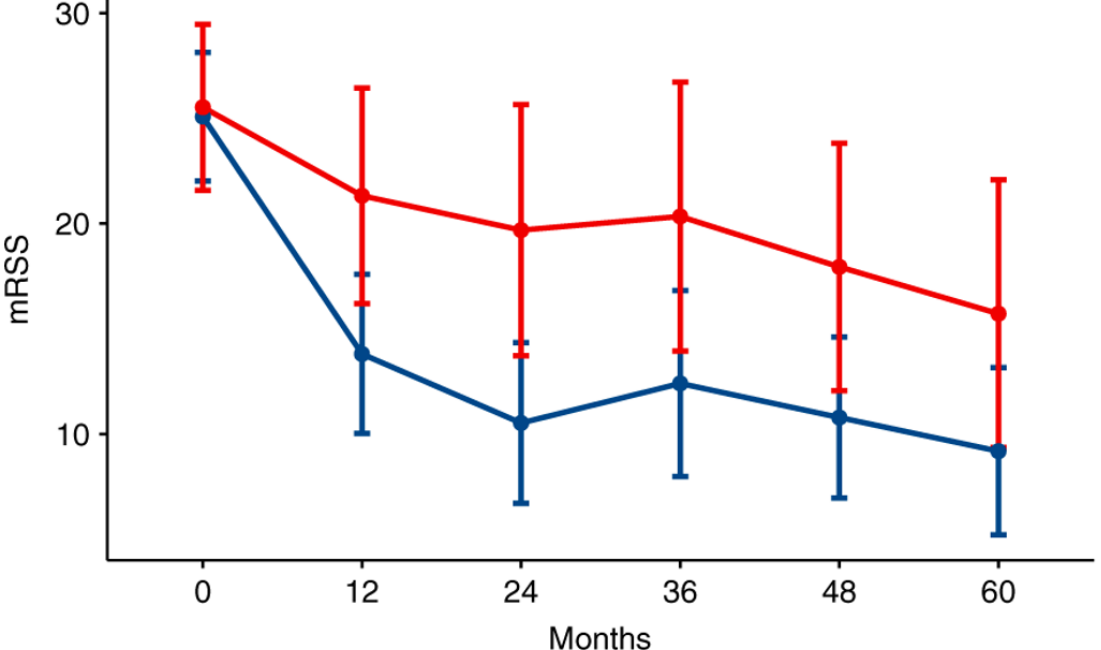
Figure 2. Change in modified Rodnan skin score [mRSS], where larger scores indicate worse skin tightness) over 60 months from randomization in 26 patients treated with autologous hematopoietic cell transplantation (auto-HCT: blue line) vs. 23 patients treated with conventional therapy (12 months of IV cyclophosphamide: red line) [67]. The skin tightness improved faster and to a greater degree after HCT compared to the conventional therapy. Reproduced with permission from Springer Nature, Bone Marrow Transplantation; published by Springer Nature, 2021.